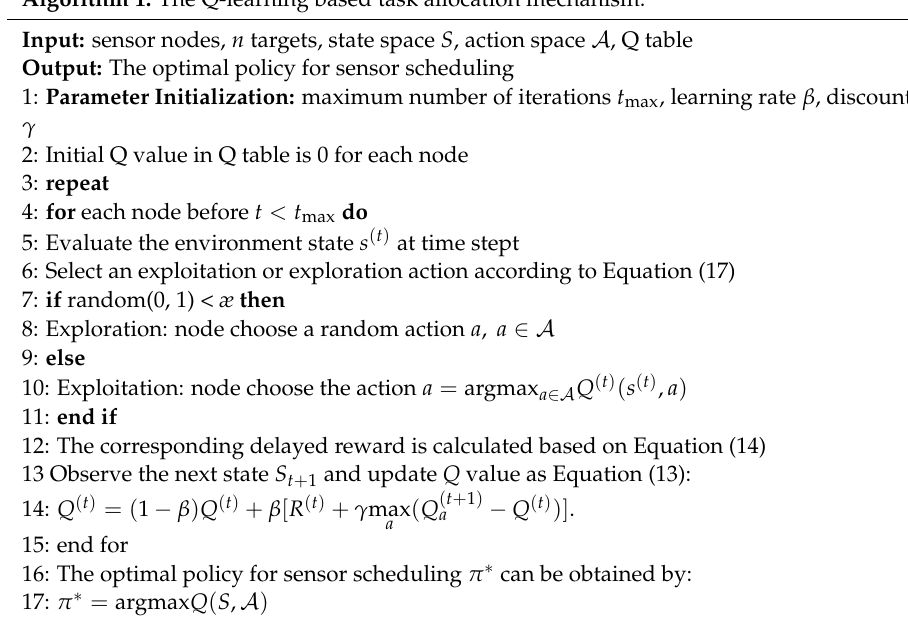
Algorithm 1. The Q-learning based task allocation mechanism.